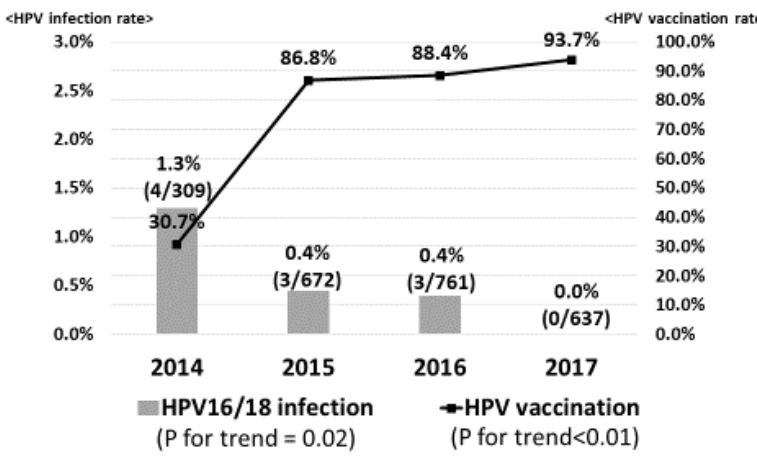
Figure 2. Prevalence of vaccine types HPV16 / 18 infection. As the HPV vaccination rate increased, the prevalence of vaccine types HPV16 / 18 infection significantly decreased from 1.3% in 2014 to 0.5% in 2015, 0.4% in 2016 and 0% in 2017, sequentially.